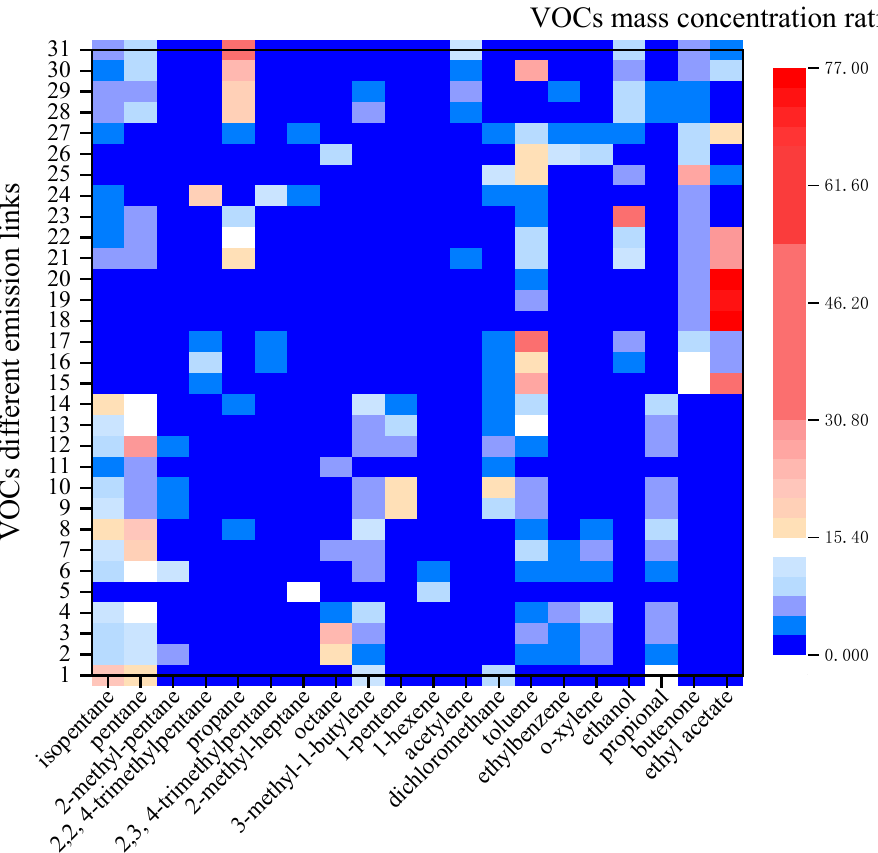
Figure 3. Main species of process links in the different industries.